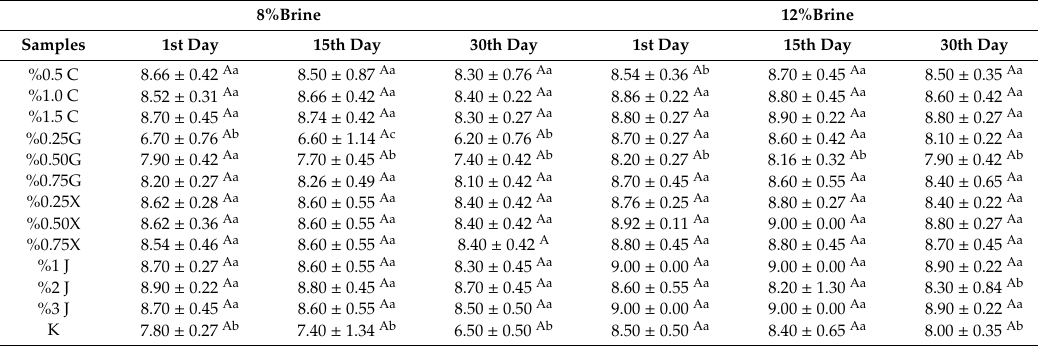
Table 14. Sensorial texture score of cheese samples during storage.